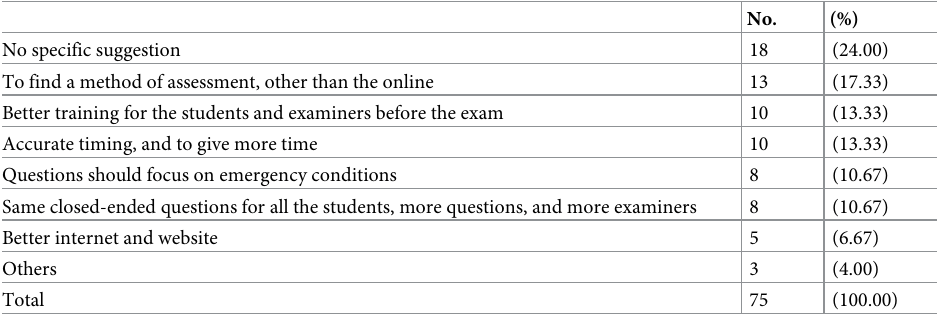
Table 4. Students’ suggestions for